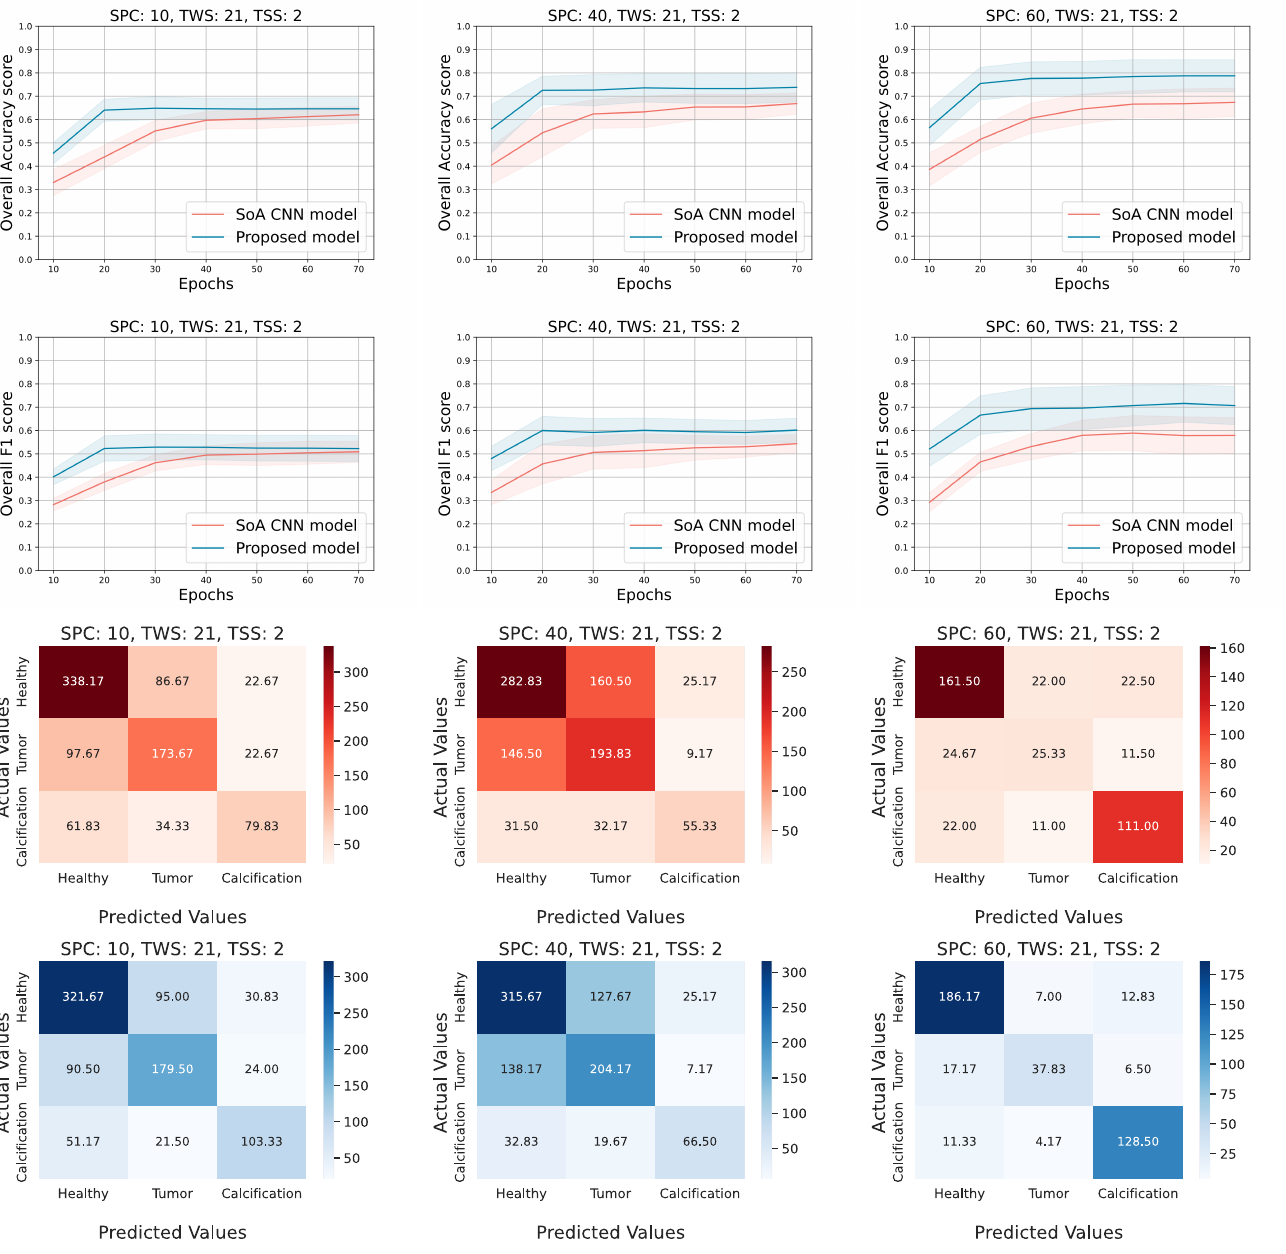
Figure 4. Experimental results for the following configuration; TWS = 21, SPC = (10, 40, and 60) and TSS = 2. The overall accuracy and F1 scores on the testing set are presented in the first two rows respectively. The rest of the rows correspond to the confusion matrices of the CNN (red hues) compared to our approach (tensor-based model (blue